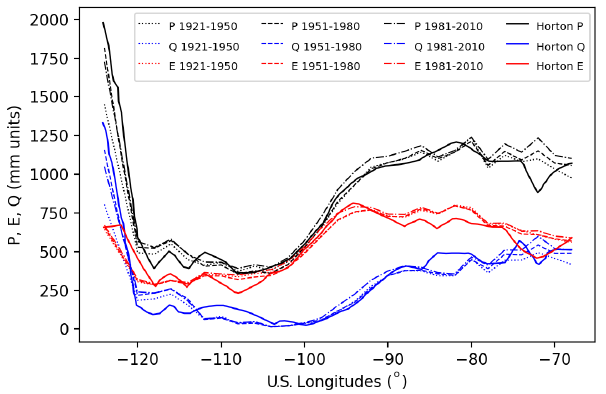
Figure 2. Comparison of continental U.S. 2 ◦ average values of pre- cipitation ( P ), evapotranspiration ( E ), and runoff ( Q ) estimates. We replotted the chart from Horton (1943b) together with Livneh et al. (2013) over three climate